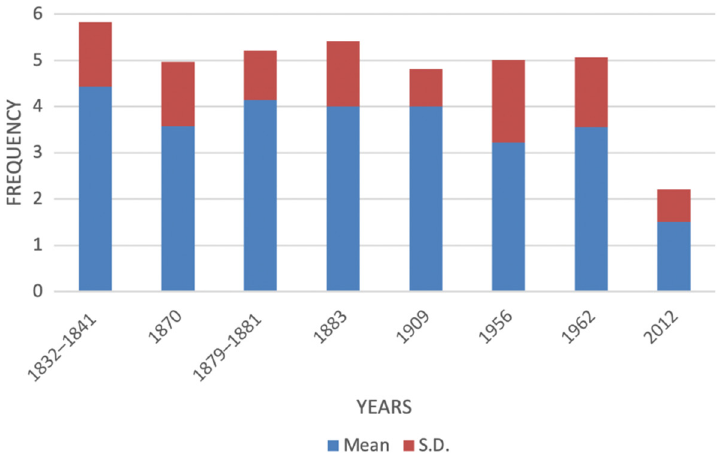
Figure 2. Frequency of species recorded in the different references.